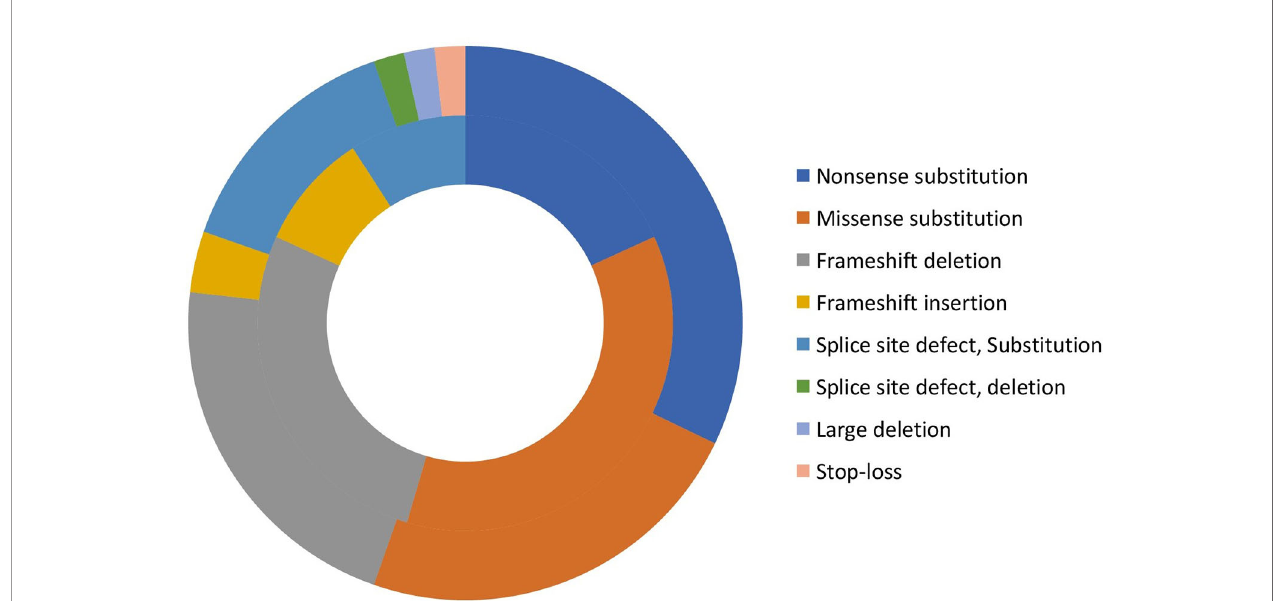
FIGURE 2 | Distribution of variants in XLT, and classic WAS patients (Inner circle: XLT, and outer circle: